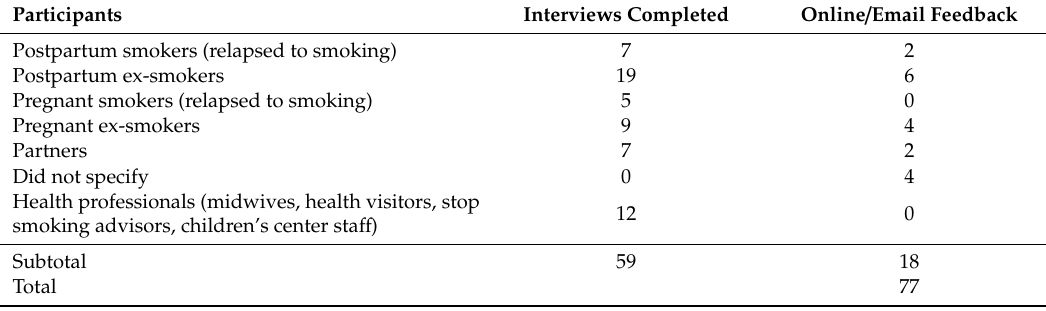
Table 1. Participant